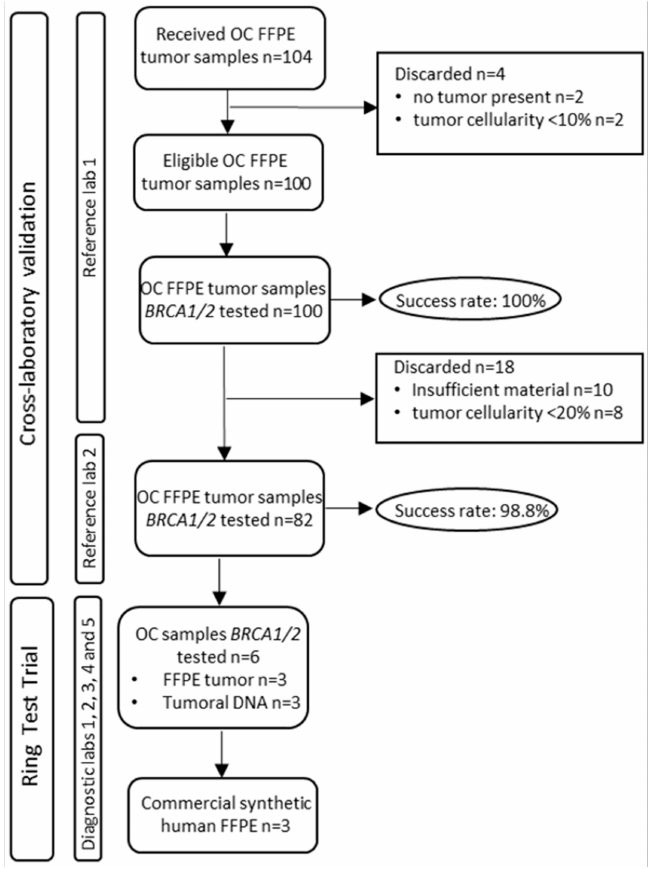
Figure 1. Sample selection